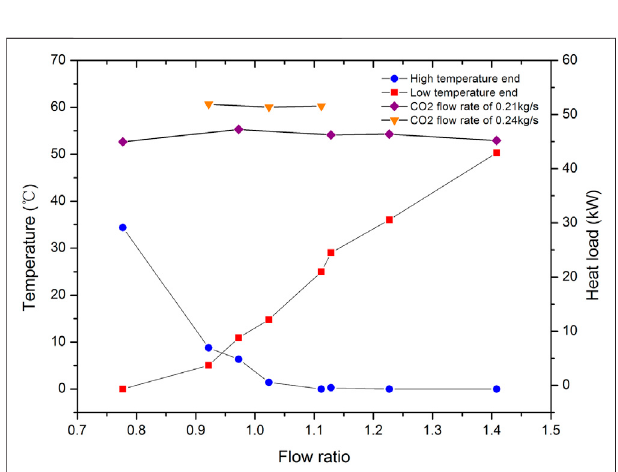
FIGURE 6 | Variation of temperature difference and heat transfer power with the fl ow